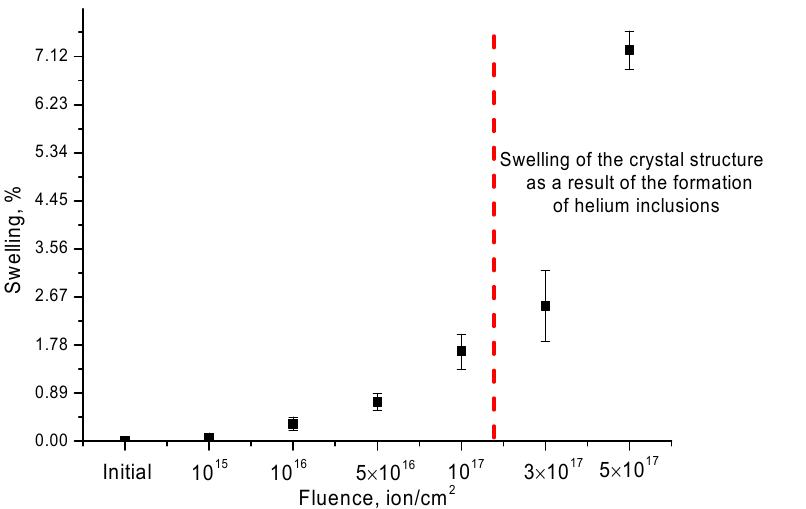
Figure 7. Results of the crystal structure swelling upon irradiation with He 2+ ions (the red dotted line indicates the boundary after which an exponential increase in swelling of the crystal structure).